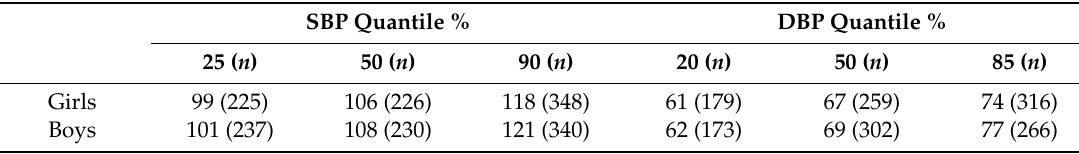
Table 2. Data distribution per quantile of SBP and